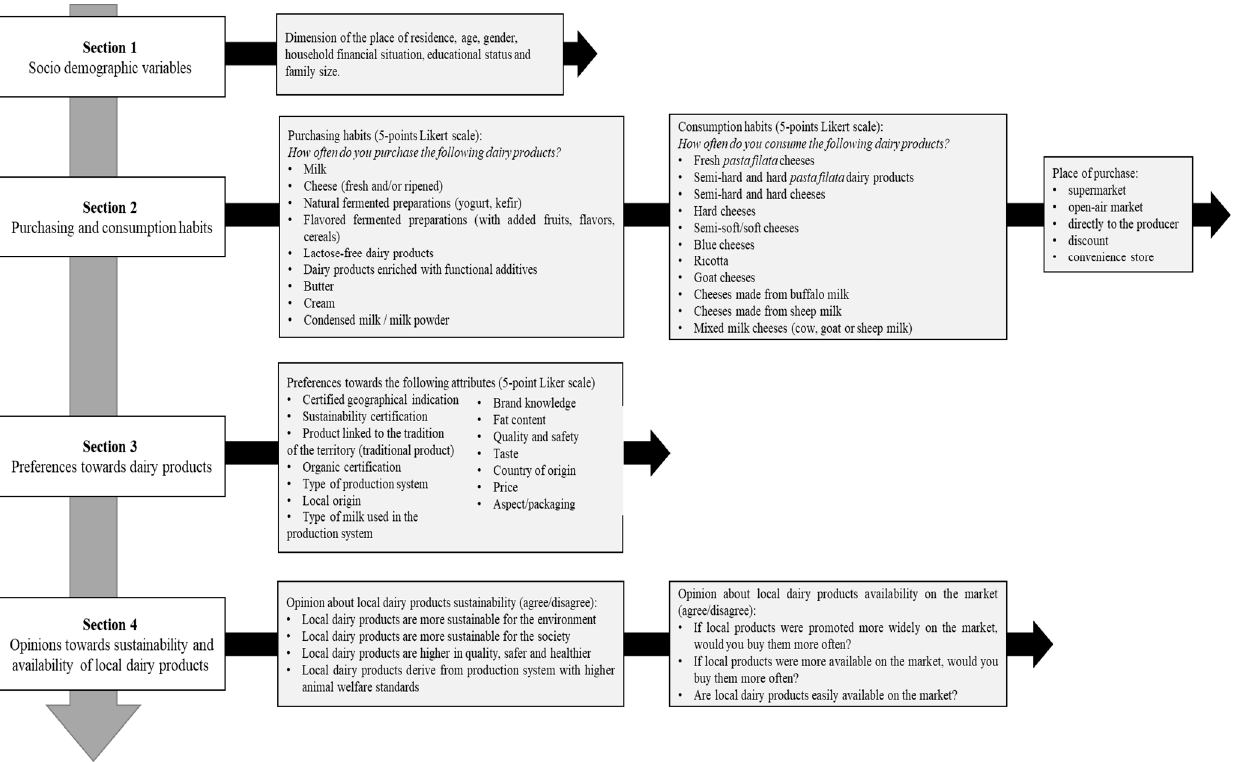
Figure 1. Flowchart of the questionnaire used to explore consumers’ preferences, perceptions, habits of purchasing, and consumption of local dairy products.